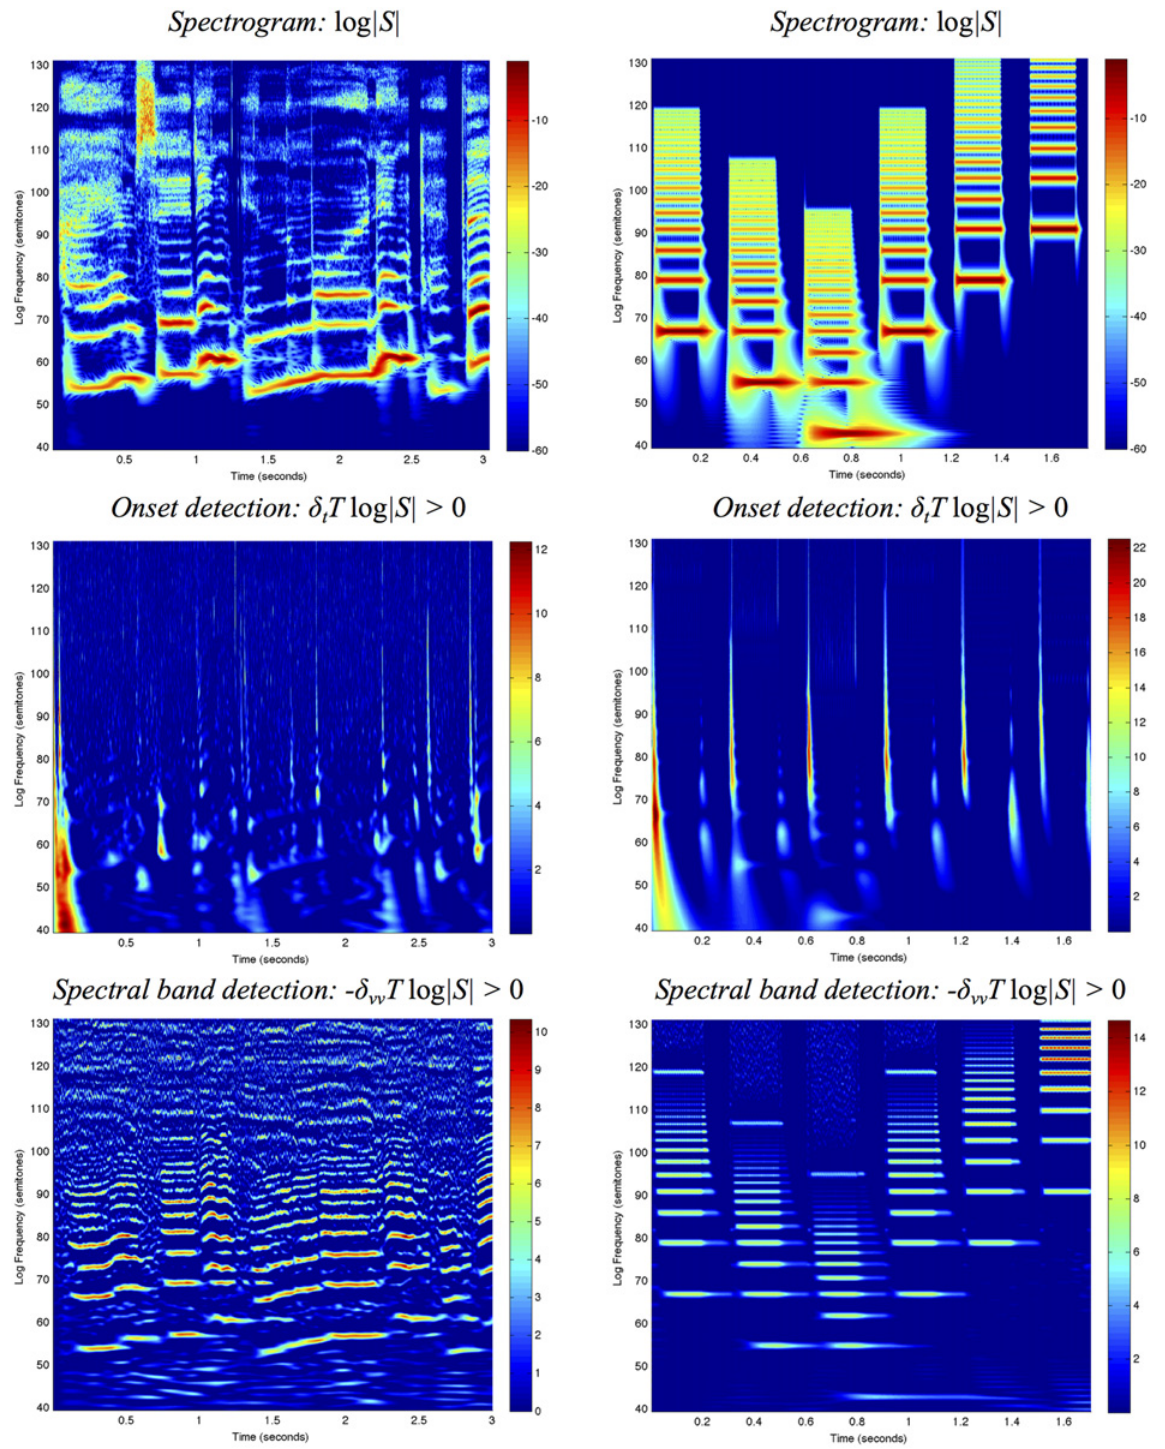
Fig 11. Second layer receptive field responses obtained by applying spectro-temporal scale-space derivatives to the logarithmic spectrogram of (left column) the first 3 seconds of “ Tom ’ s diner ” by Suzanne Vega with the lyrics “ I am sitting in the morning at the ... ” or (right column) a synthetic signal containing of harmonic spectra with 20 partial tones and a spectral slope of 6 dB/octave at different fundamental frequencies: (top row) Original spectrogram. (middle row) Onset detection from the positive part of the first-order temporal derivatives @ t T log j S j > 0 using a cascade of four time-recursive filters with temporal scale proportional to the temporal window scale s